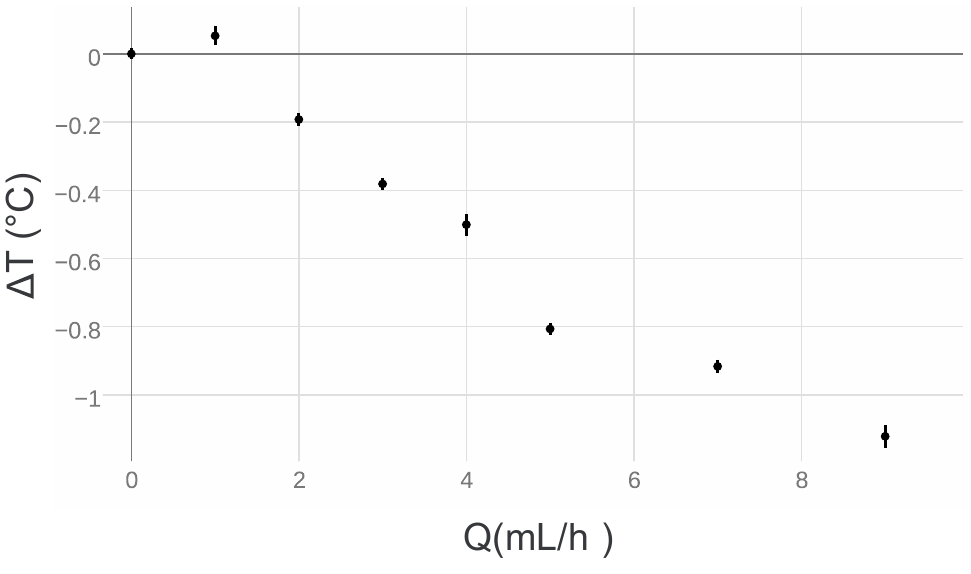
Figure 3. Device response with respect to flow rate. The difference ∆ T between the temperature recorded by the device and the average syringe temperature was computed for across a range of flow rates Q of deionized water in the assembly shown in Figure 2. Data were shifted by the difference measured in the condition of no flow ∆ T (0 mL/h), providing an empirical assessment of the flow rate-dependent offset between measured temperature and fluid temperature. The thermistor appears to perform with little variation to measured temperature at low flow rates. Microfluidic flow appears to cool the thermistor starting around 2 mL/h. Error bars shown represent the standard deviation of data collected during the recording period.